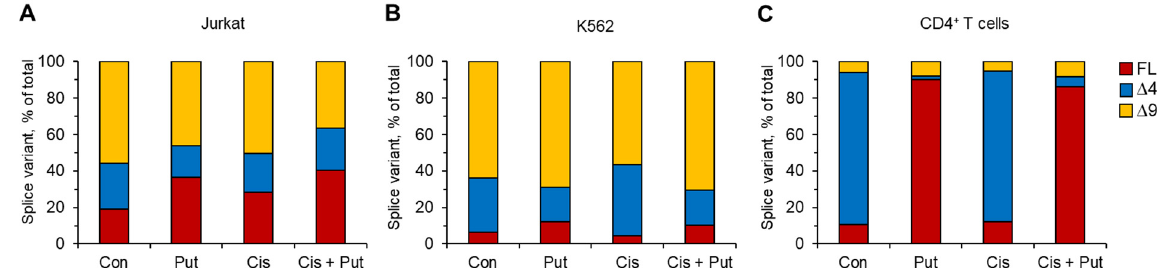
Figure 5. Induction of alternative splicing of RAD51A pre-mRNA by Put. mRNA levels of RAD51 splice variants measured by real-time RT-PCR in cancer cell lines ( A ) Jurkat, ( B ) K562, or ( C ) normal CD4 + T lymphocytes pretreated with Put and incubated with cisplatin (Cis). mRNA levels of splice variants were normalized relative to the expression of the reference gene 18S . n = 4. FL: full-length splice variant. ∆ 4: mRNA splice variant with the deletion of exon 4. ∆ 9: mRNA splice variant with the deletion of exon 9.